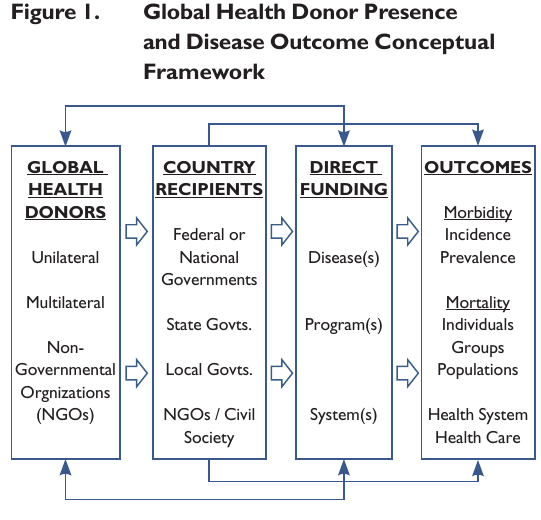
Figure 1. Global Health Donor Presence and Disease Out come Conceptual